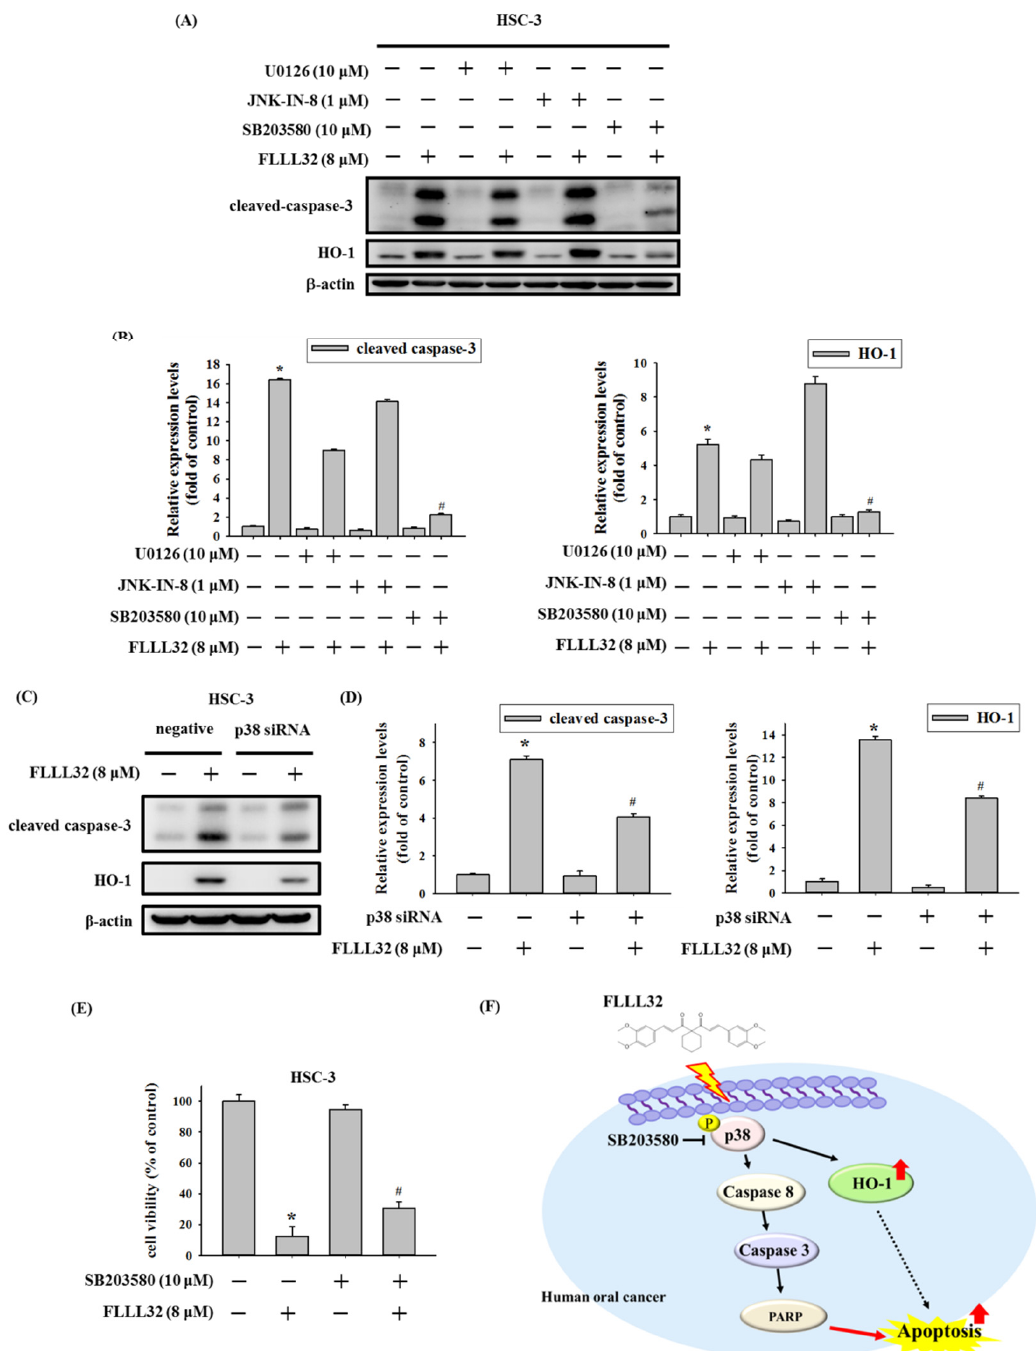
Figure 7. Involvement of p38 in FLLL32-induced activation of caspase-3 and HO-1. ( A ) HSC-3 cells were pretreated with U0126 (10 µ M), JNK-IN-8 (1 µ M), or SB203580 (10 µ M) for 2 h, before treatment with FLLL32 (8 µ M) for 24 h. The protein levels of cleaved caspase-3 and HO-1 were analyzed by Western blot. ( B ) Quantitative results of the protein levels of cleaved caspase-3 and HO-1 from ( A ). β -actin protein levels were used to adjust the quantitative results of protein levels. ( C ) The combined effect of p38 siRNA and FLLL32 (8 µ M) on cleaved caspase-3 and HO-1 was analyzed by Western blot. ( D ) Quantitative results of the protein levels of cleaved caspase-3 and HO-1 from ( C ). β -actin protein levels were used to adjust the quantitative results of protein levels. ( E ) The combined effect of SB203580 (10 µ M) and FLLL32 (8 µ M) on cell viability; * p < 0.05 compared with the vehicle group; # p < 0.05 compared to the FLLL32-only treated group. ( F ) Proposed model for the anticancer effects of FLLL32 in oral cancer cells. In oral cancer cells, curcumin analog FLLL32 can induce cell apoptosis by activating caspase-3, PARP, and HO-1 through the p38 pathway.